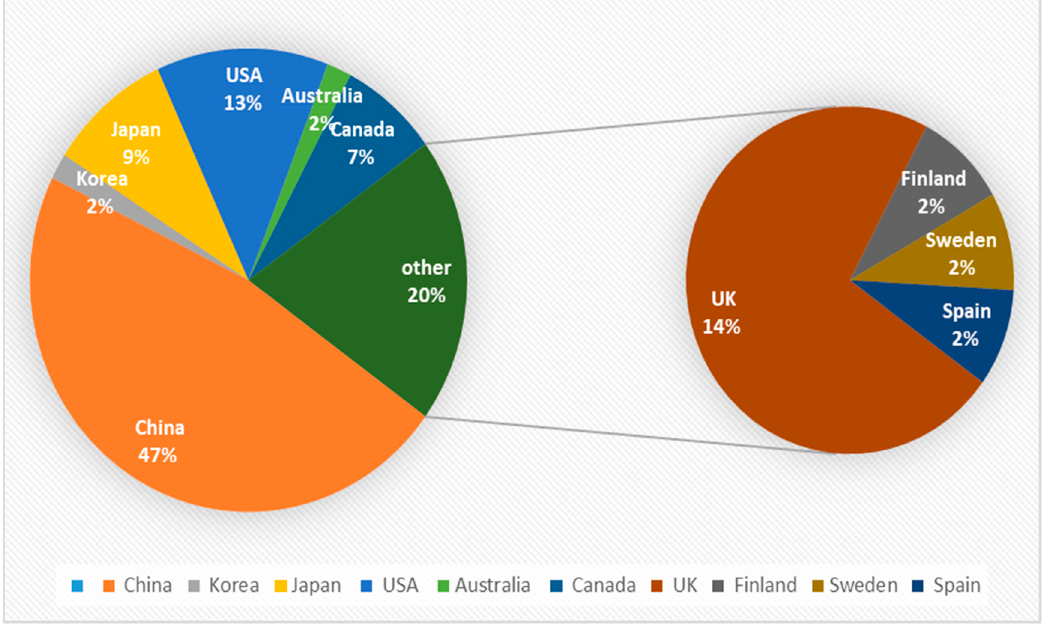
Figure 3. Classification of publication by year.